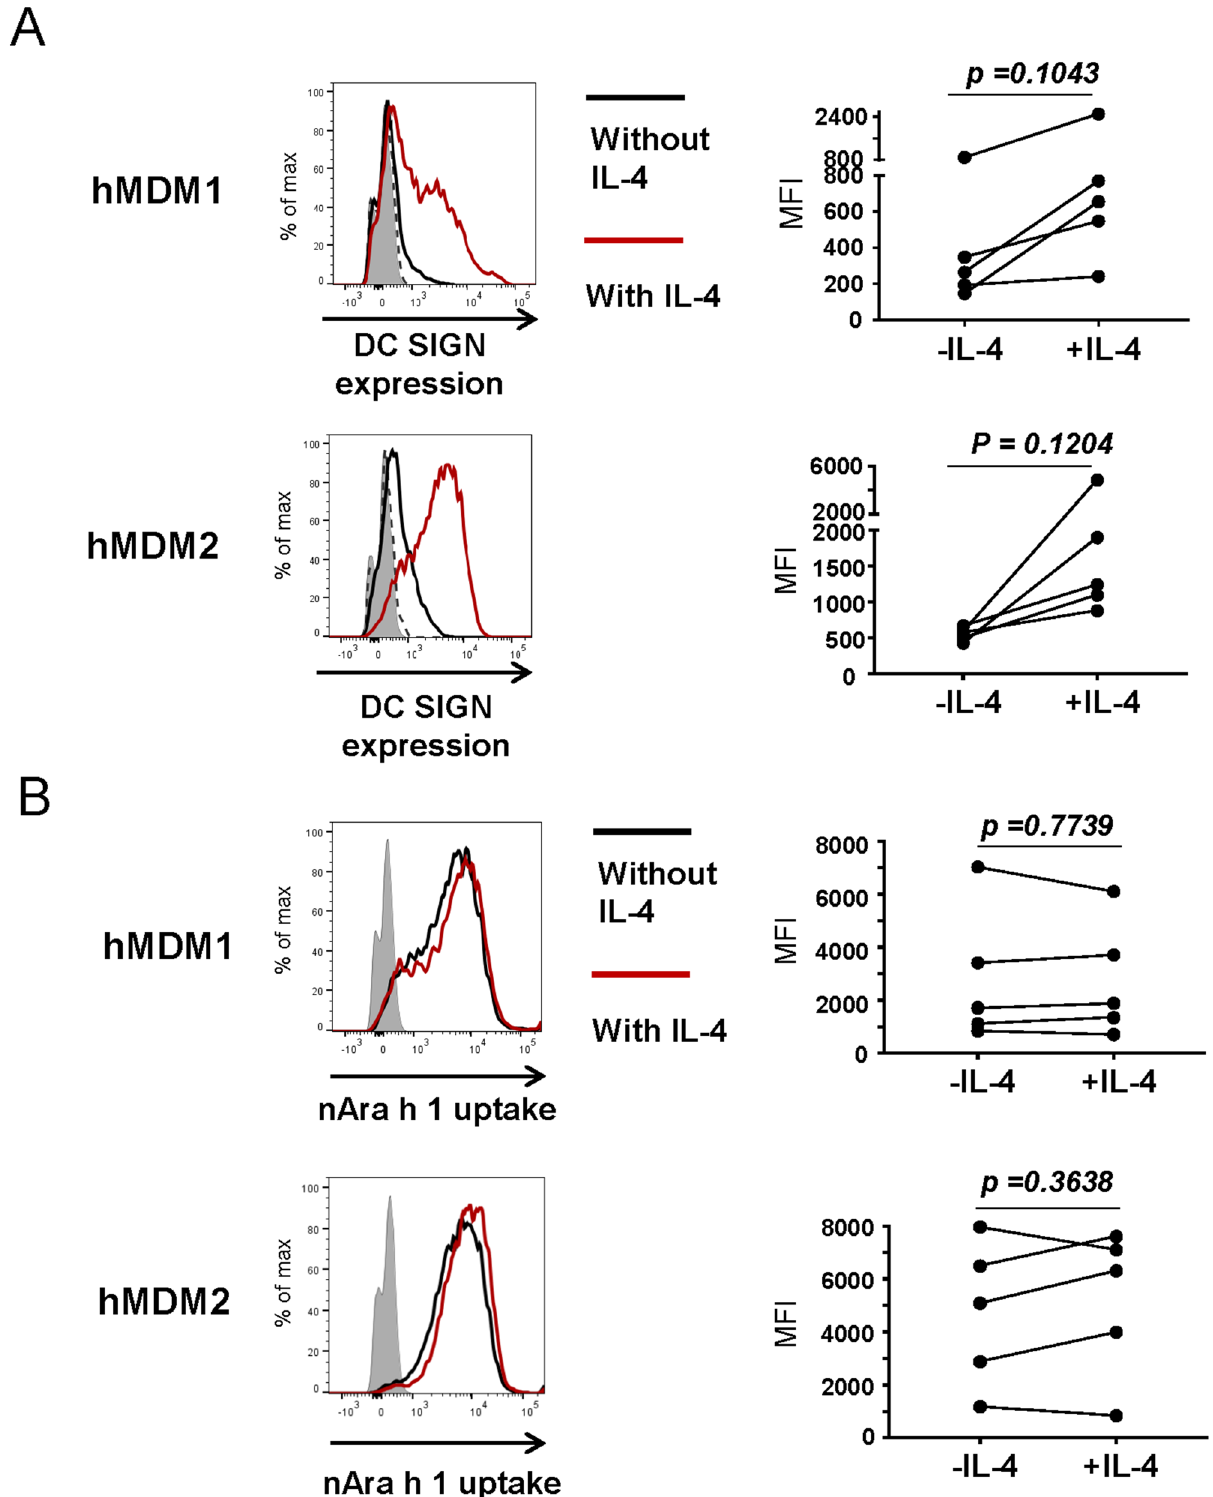
Figure 6. IL-4 enhanced DC-SIGN expression but not nAra h 1 uptake by hMDM1 and hMDM2. hMDM1 and hMDM2 were cultured in the absence or presence of 10 ng/ml of IL-4. ( A ) Expression levels of DC-SIGN were measured by FACS. Grey area: cells without any treatment and staining, dashed line: cells cultured with IL-4 and stained with an isotype control Ab, black line; cells cultured without IL-4 and stained with anti-DC-SIGN mAb, red line: cells cultured with IL-4 and stained with the mAb. ( B ) Uptake levels of FITC-nAra h 1 by the cells were measured by FACS. Grey area: cells without treatment and staining, black line; cells cultured without IL-4 and treated with FITC- nAra h 1, red line: cells cultured with IL-4 and FITC-nAra h 1. Each set of symbols connected by a line represents data from cells of an individual donor. The data represent three independent experiments using five donors in